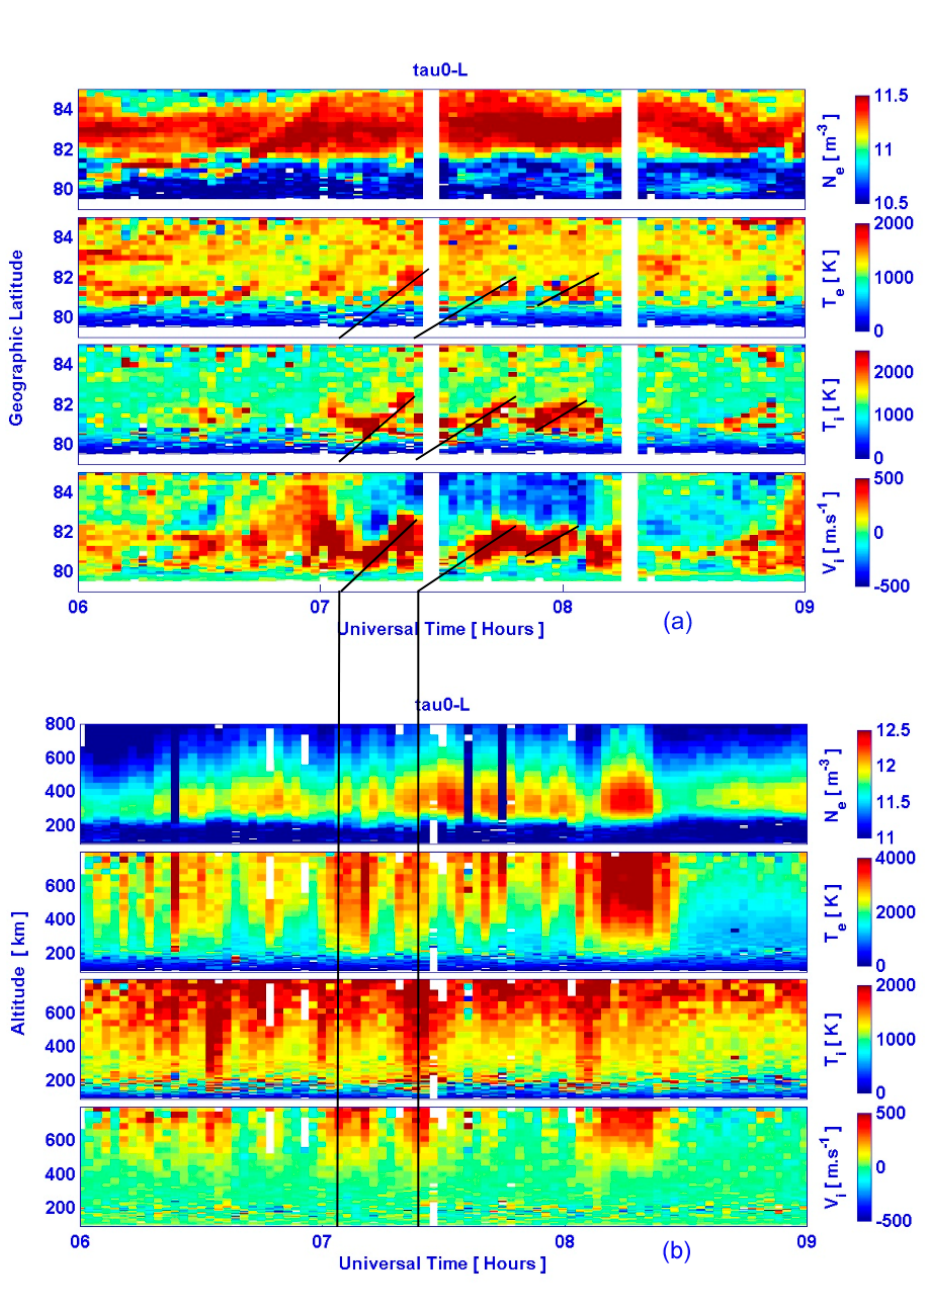
Fig. 2. Plasma parameters measured by the northward pointing ESR dish and the field-aligned dish on 26 November 2000. From top to bottom: N e , electron density, T e , electron temperature, T i , ion temperature, and line-of-sight velocity, V i (positive away from the radar) as a function of time and geographic latitude (a) or altitude (b)